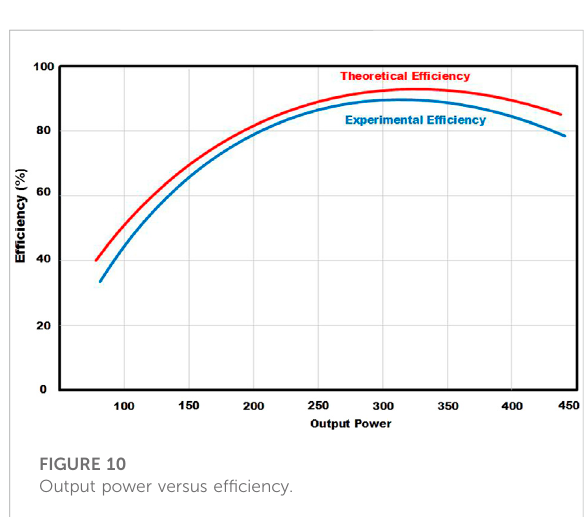
FIGURE 10 Output power versus ef fi